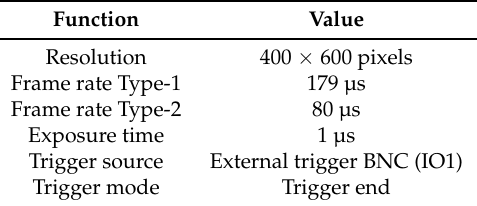
Table 1. High-speed camera settings.